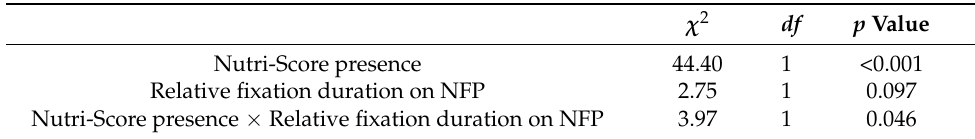
Table 10. The fixed part of the mixed-effects model with a random slope for relative fixation duration on NFP in the subset of participants exposed to products with